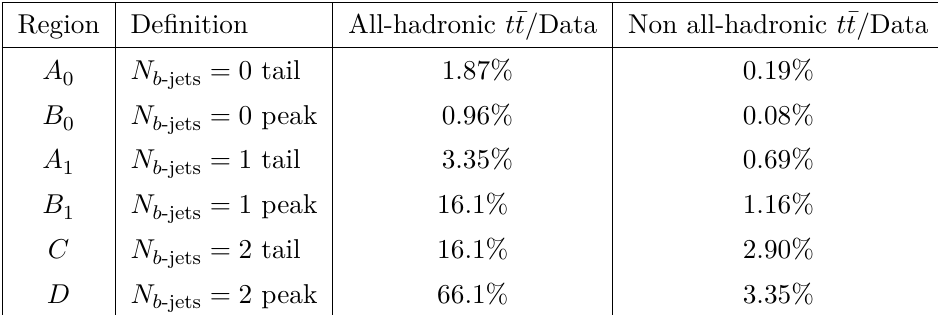
Table 5 . Fractional yields from top-quark pair production processes in the different regions, defined by the values assumed by N and the two top-quark masses m b -jets